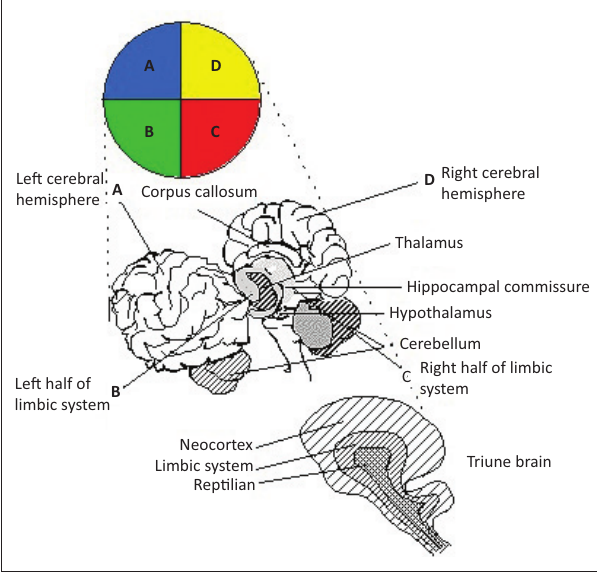
FIG URE 2: The triune brain theory combined with the left-brain/right-brain theory which emerged into the four-quadrant